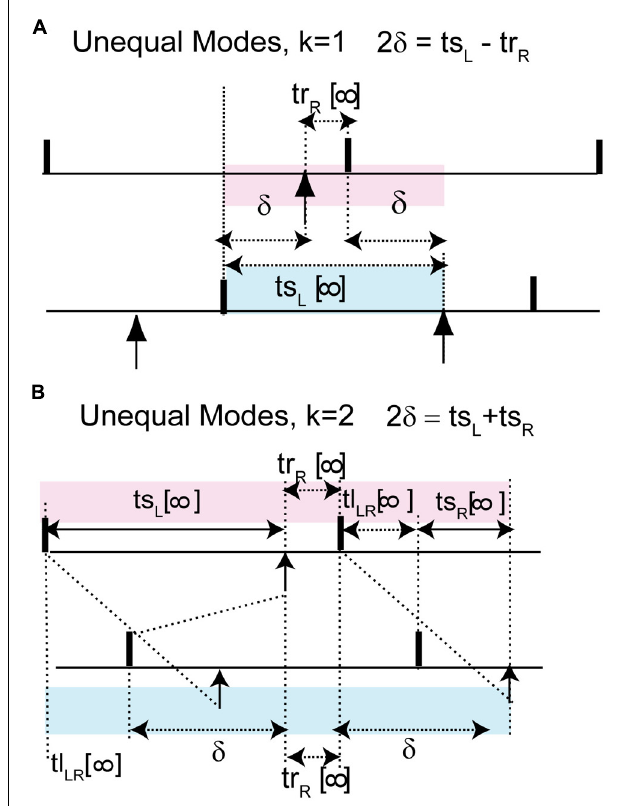
FIGURE 7 |The leader–follower modes persists approximately as unequal time lag modes in models with more realistic coupling. Unlike the leader–follower mode here the recovery interval of the neuron on the right branch is not 0. (A) For k = 1, 2 δ + t r R = t s L , where 2 δ + t r R is shaded in pink and t s L in blue.The normalized delay after substitution of the recovery and stimulus interval can be rewritten as δ / P = ( φ L + φ R )/2 − [1 + f ( φ R )]/2.This gives a criterion for non-negative delay. (B) For k = 2, 2 δ = t s L + t s R .This is obtain by noting that the sum of the pink intervals t s L + t r R + t l LR + t s R is equal to the sum of the blue intervals t l LR + δ + t r R + δ and canceling t r R + t l LR from both sides. Normalized delay is equal to the average of the phase locking points: δ / P = ( φ L + φ R